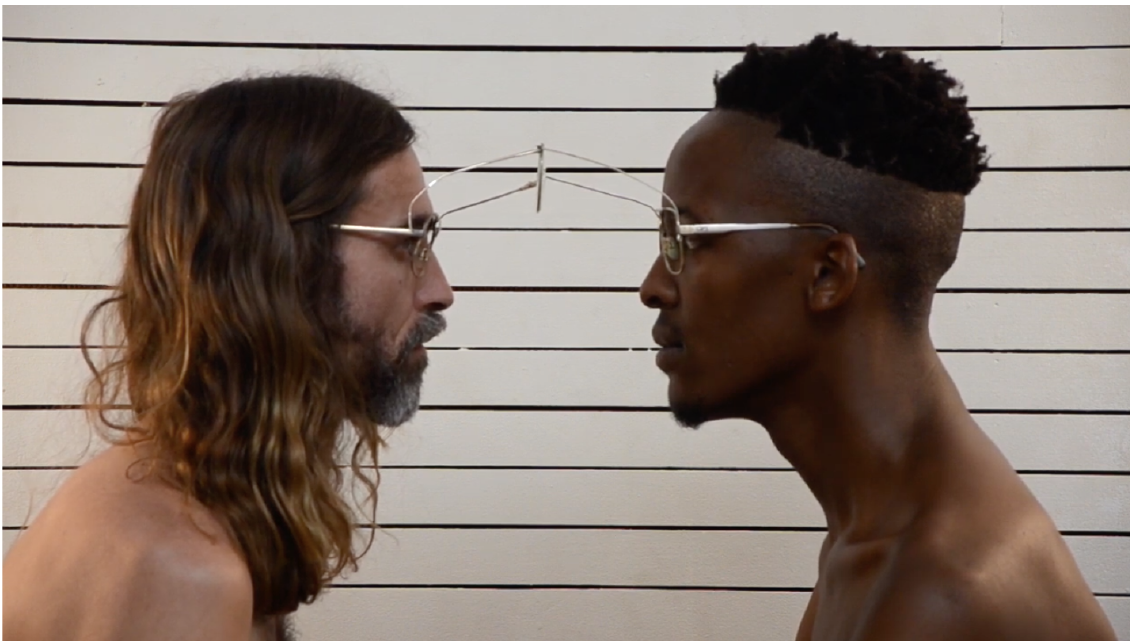
Figure 1 : “III”: a social sculpture first performed by myself McGarry (left) and Sizo Mahlangu (right) in August